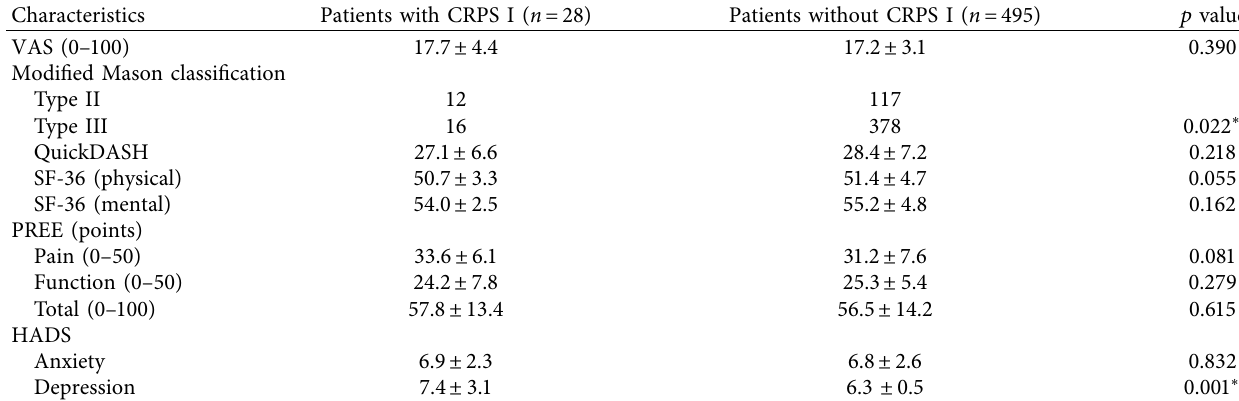
Table 2: Clinical characteristics of study sample.